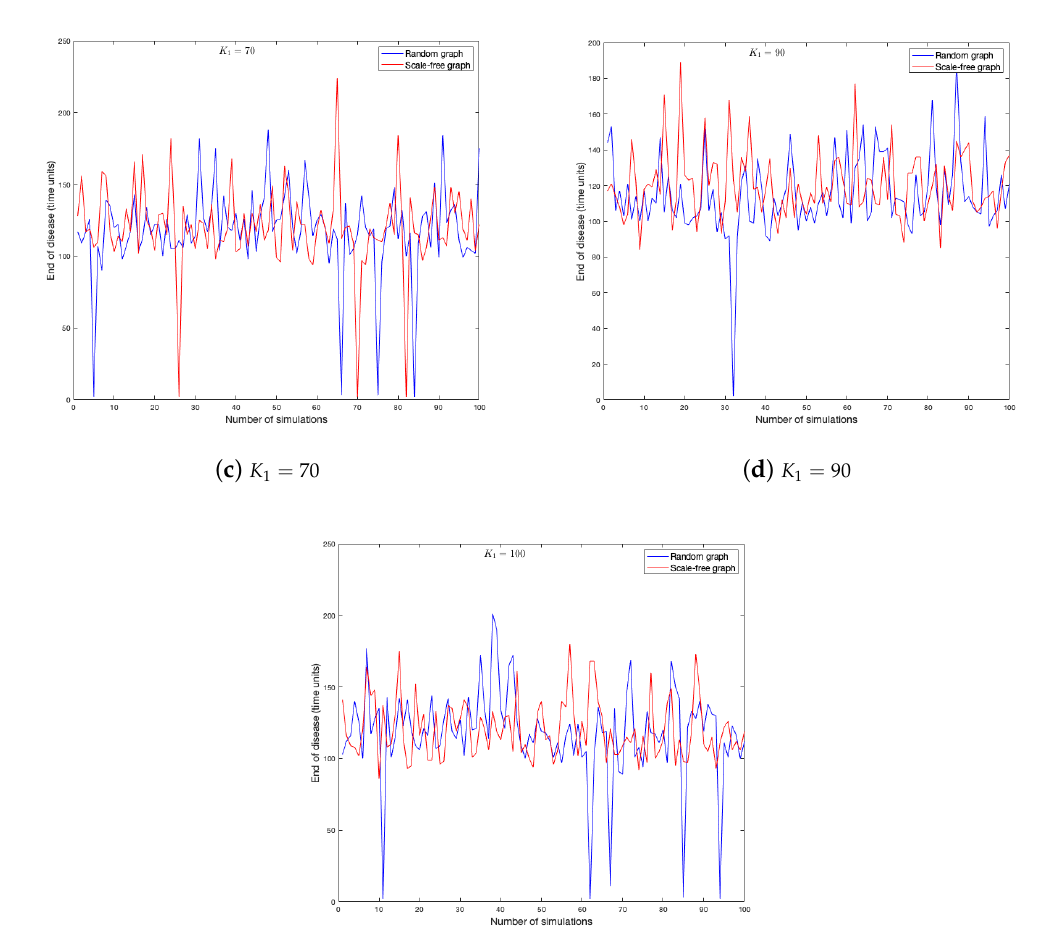
Figure 12. End of disease for different K 1 in random and scale-free graph.